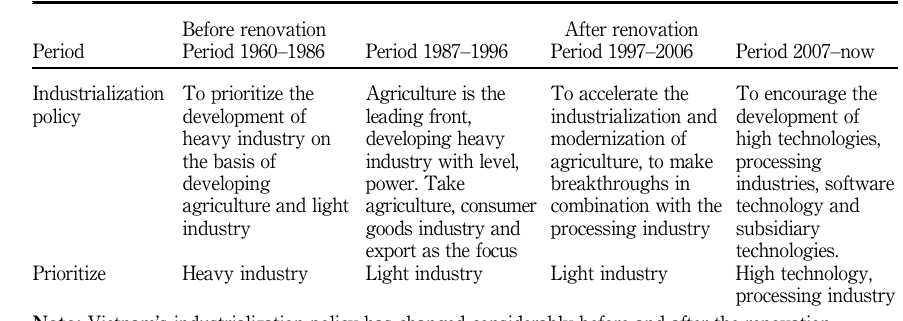
industrialization policy before and after